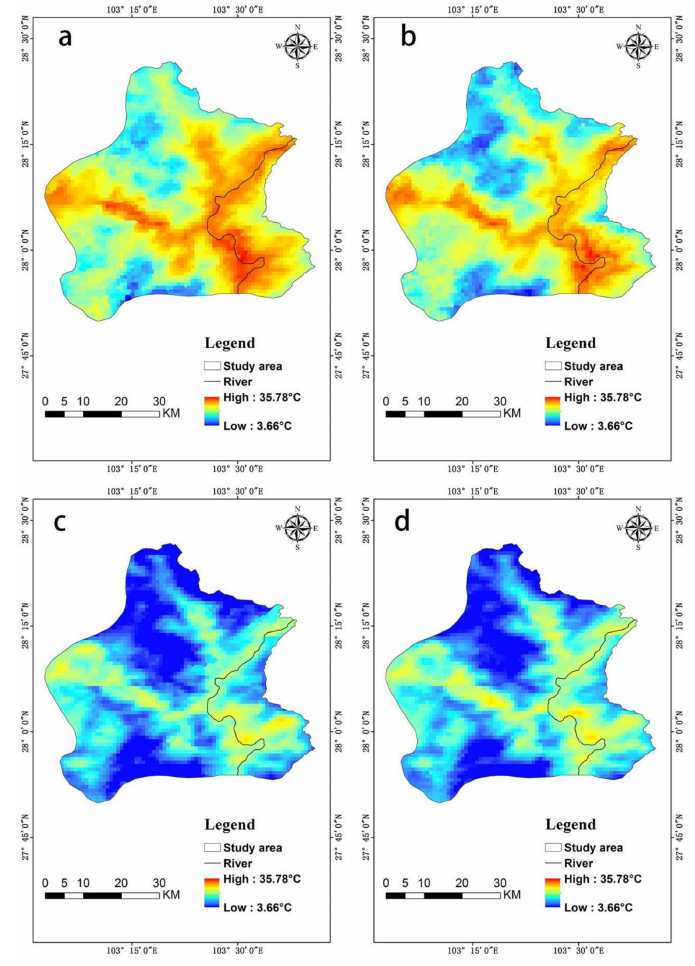
Figure 2. ( a ) Temperature distribution in wet season before HSC; ( b ) temperature distribution in wet season after HSC; ( c ) temperature distribution in dry season before HSC; and ( d ) temperature distribution in dry season after